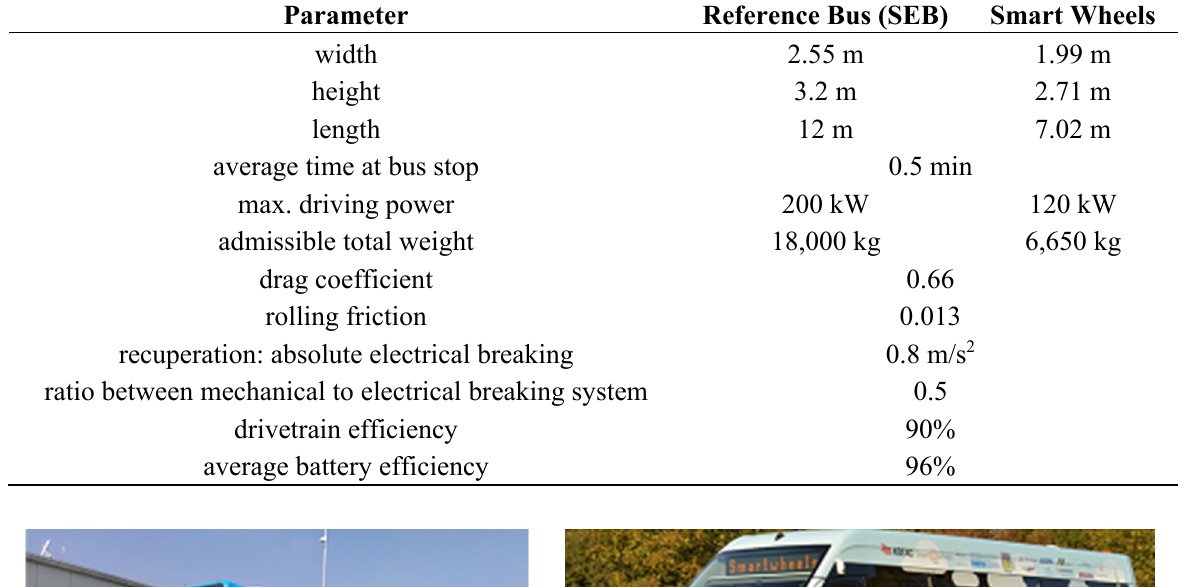
Table 3. Reference system for a 12 m full electric bus used to calculate the energy consumption on different bus routes.